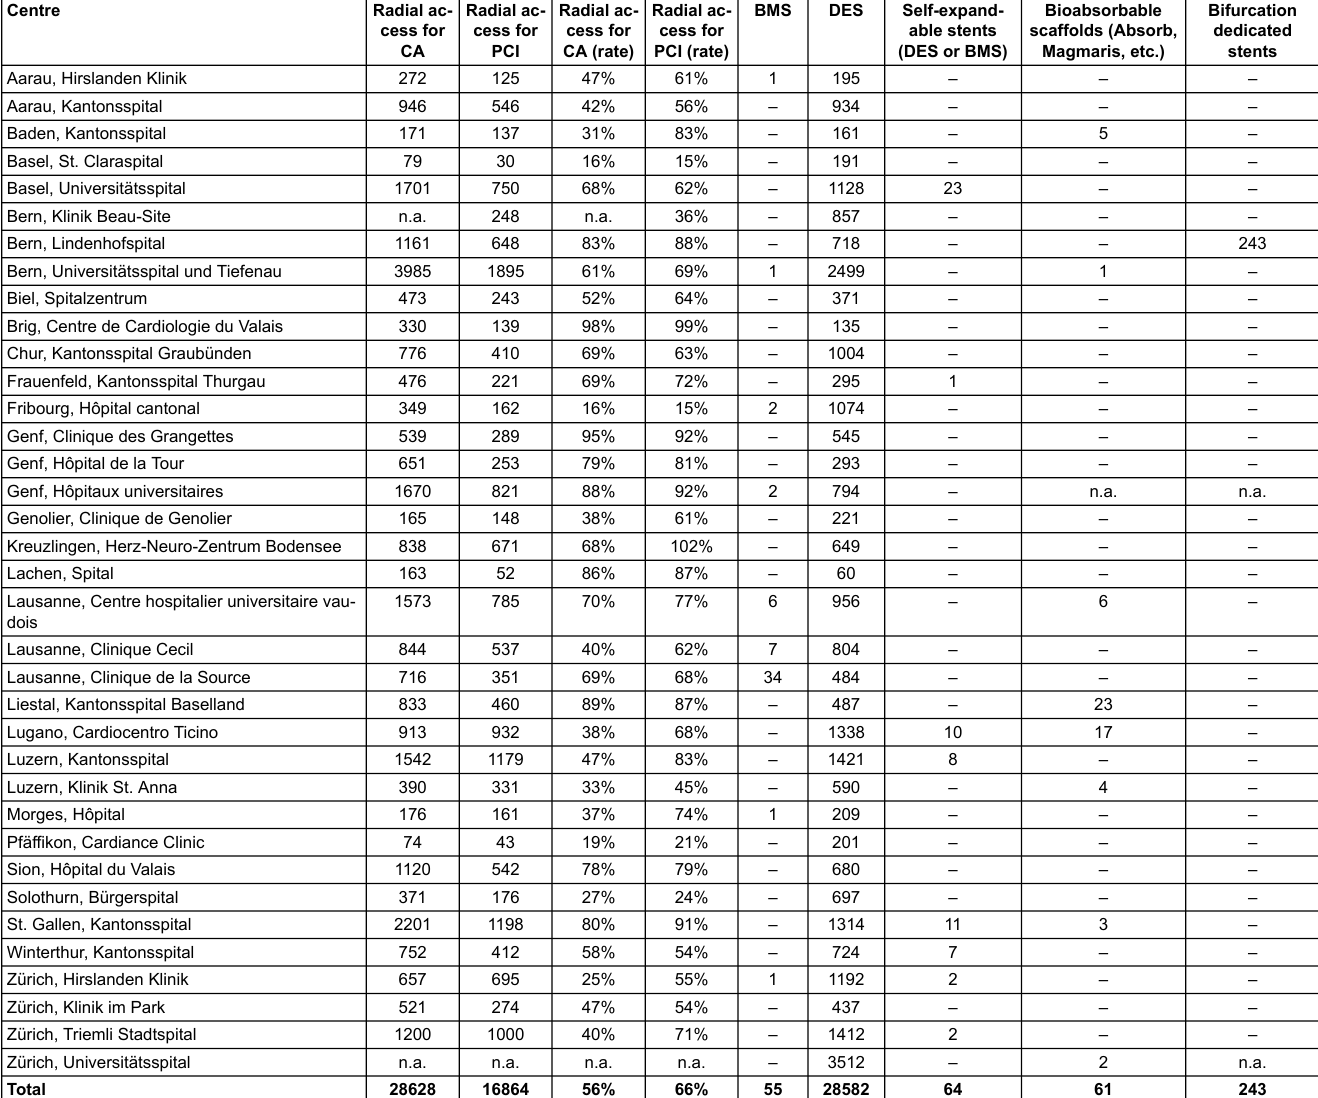
Table 3: Characteristics of the coronary interventions: access and stenting. Centre Radial ac-